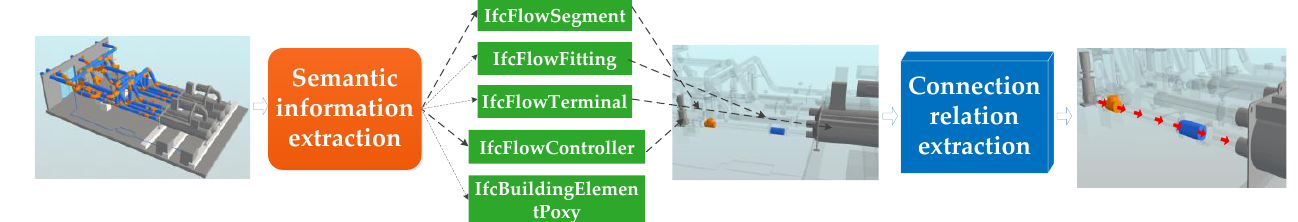
Figure 12. The framework of the direction